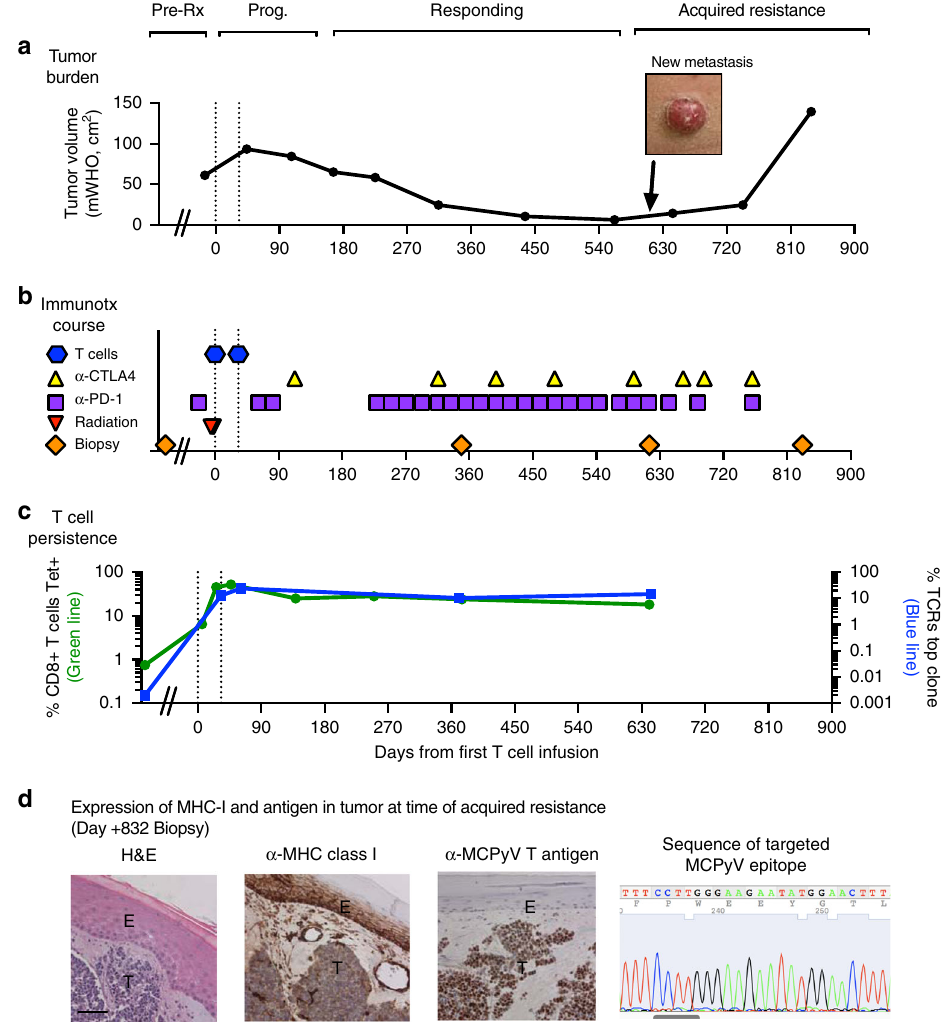
Fig. 1 Acquired resistance to combination immunotherapy. T cell infusions indicated by dashed lines. a Clinical course. b Immunotherapy treatments. c T cell persistence. CD8 + T cell persistence by MCPyV-sT 83-91 tetramer is on left axis (green line) and frequency of dominant infused clone by CDR3-beta sequencing on right axis (blue line; this clonotype was 85% of the infusion product). d Evaluation of tumor at acquired resistance/late relapse (post- treatment day + 832): Left: Immunohistochemistry demonstrating expression of MHC class I (pan-HLA – ABC) in tumor (T) and epidermis (E) and MCPyV T antigen in tumor. Scale bar indicates approximately 100 micrometers. Right: sequence of the targeted MCPyV-sT 83-91 epitope was unmutated.